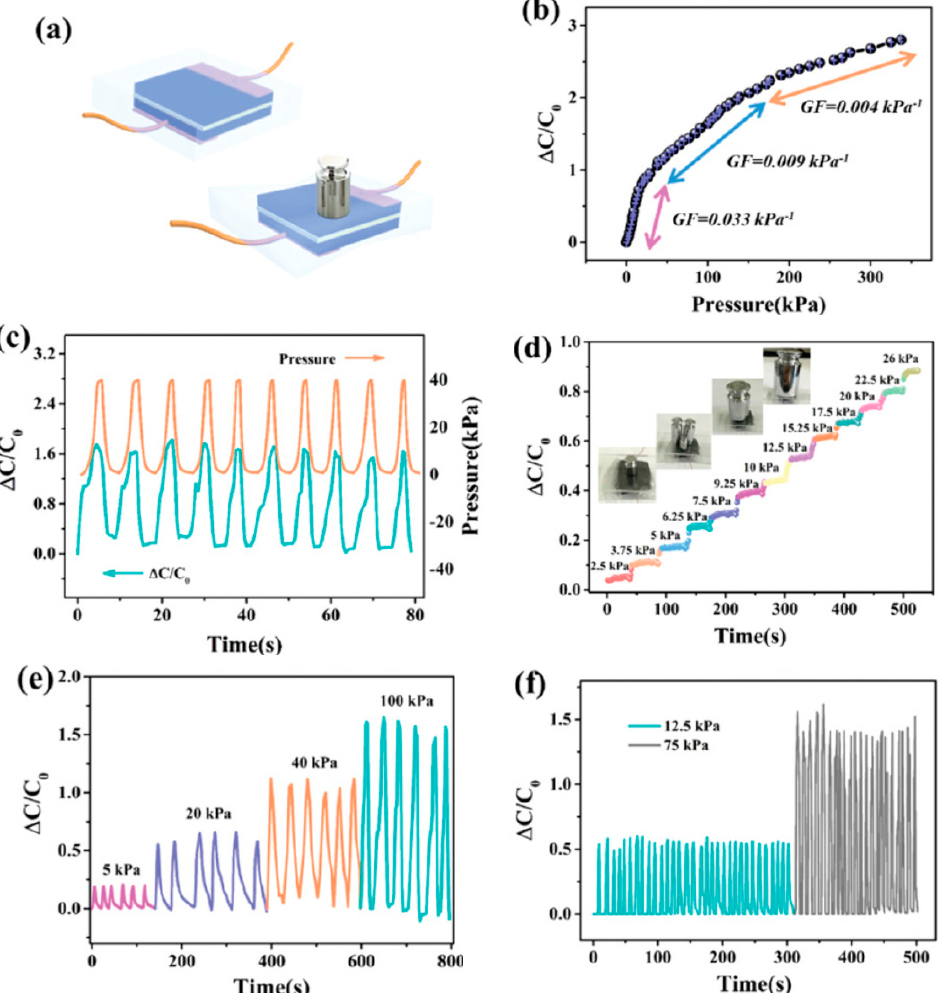
Figure 20. Proof-of-concept of the PVA / SA / BC / MCC hydrogels as a capacitive pressure sensor. ( a ) Schematic of the pressure sensor. ( b ) Relative capacitance change (RCC) as a function of the applied pressure. ( c ) RCC and pressure measured in parallel. ( d ) RCC under increasing applied pressures from 2.5 to 26 kPa. ( e ) RRC as a function of a cyclic applied pressure from 5 to 100 kPa. ( f ) RCC under compressing / releasing cycles. Reproduced from [81] with permission. Copyright © 2019 Wiley and Sons.